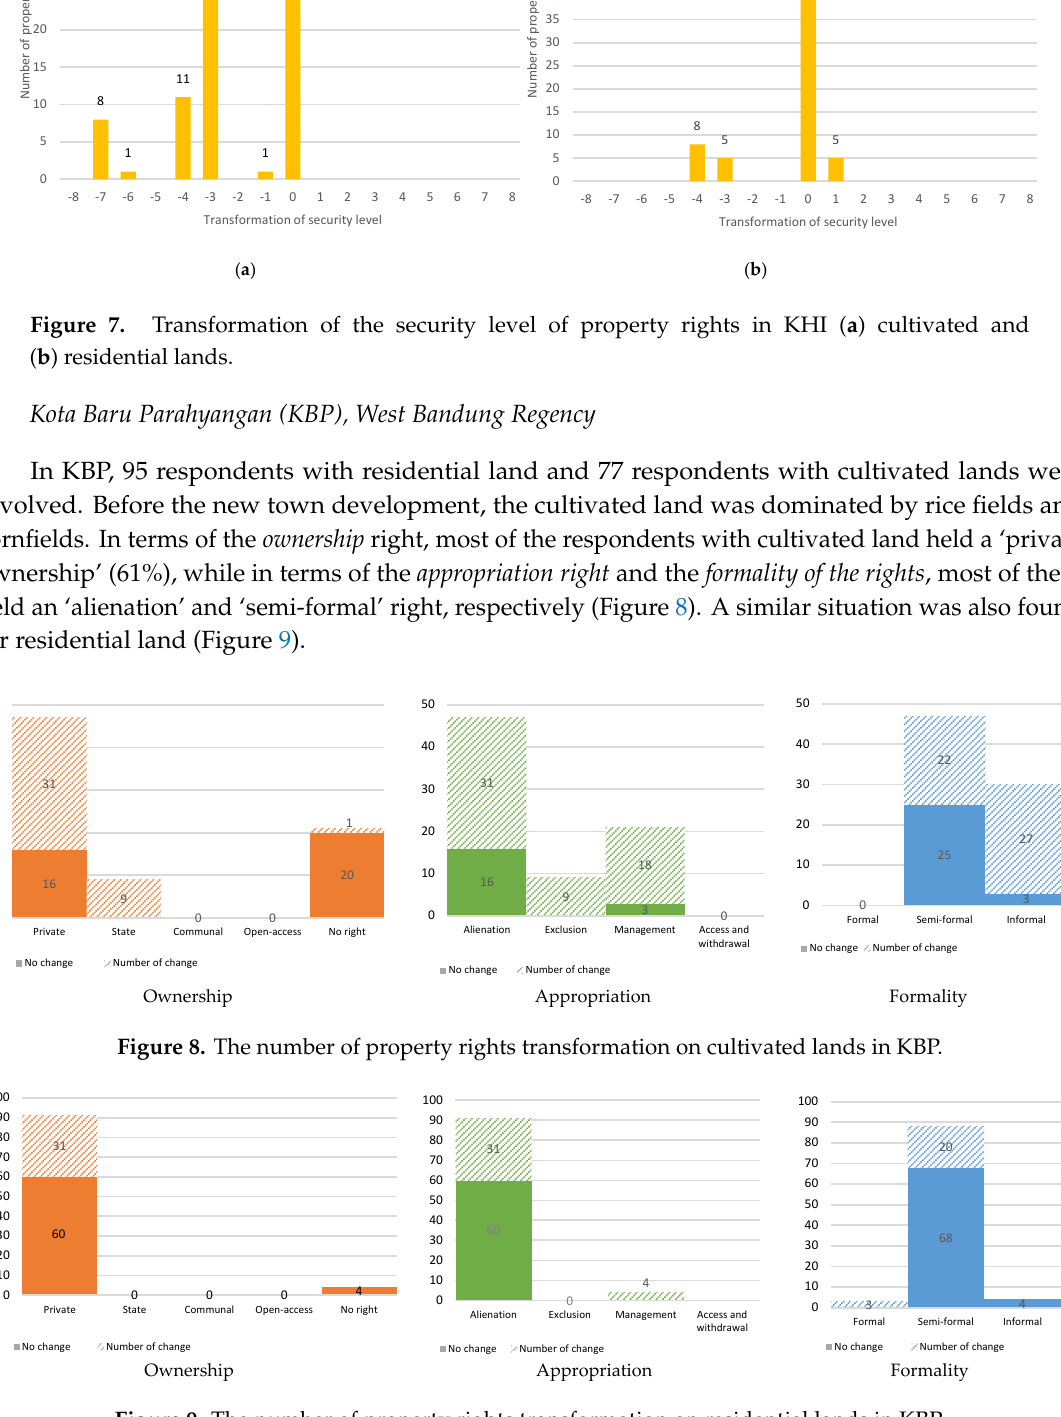
Figure 9. The number of property rights transformation on residential lands in KBP.